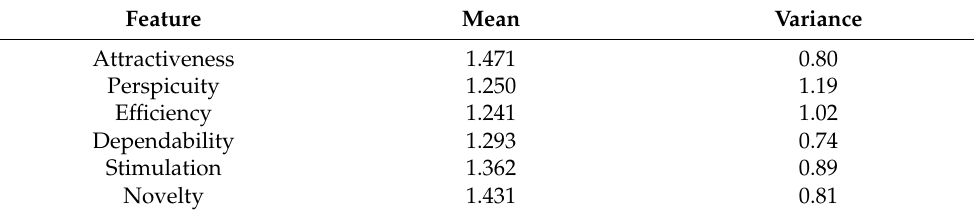
Table 6. Global evaluation—UEQ scales (mean and variance).